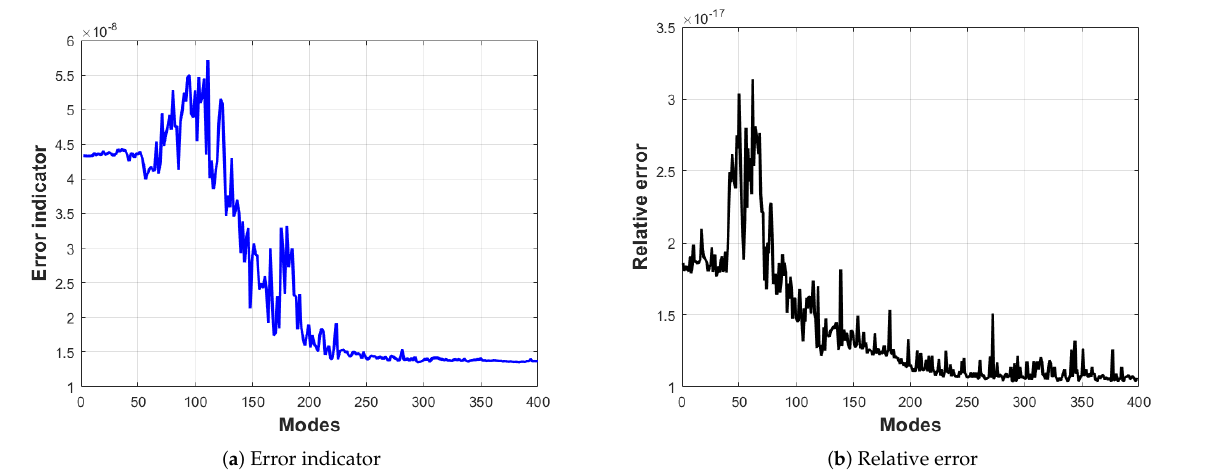
Figure 6. The evolution of ( a ) error indicator and ( b ) relative error between the Hi-Fi model and reduced-order model of the